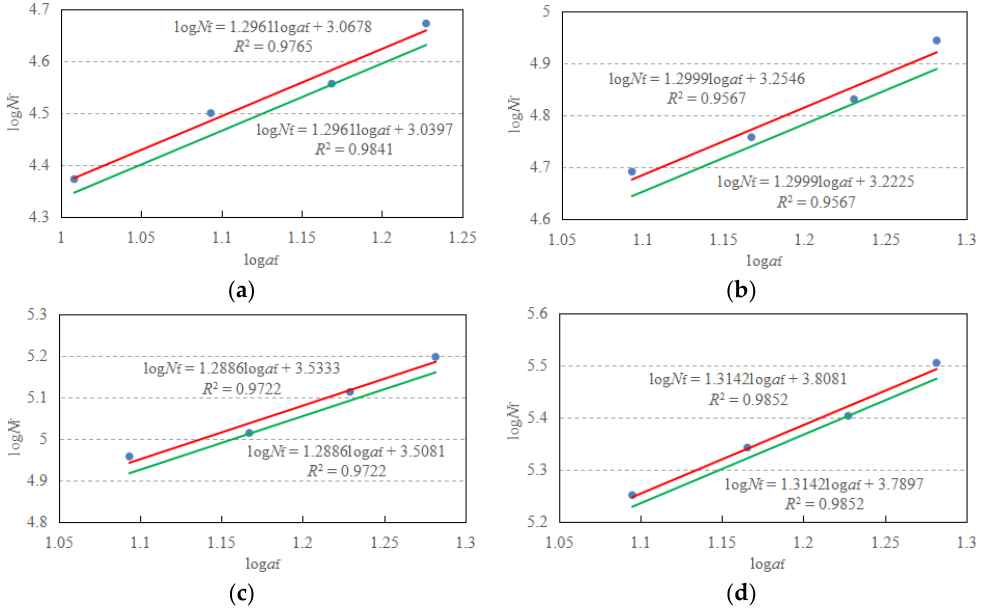
Figure 7. Fitting function of the fatigue life of the notched plate and the initiation and stable propa- gation length of the fatigue crack. ( a ) Specimens B1 – B4, ( b ) specimens B5 – B8, ( c ) specimens B9 – B12, and ( d ) specimens B13 – B16.